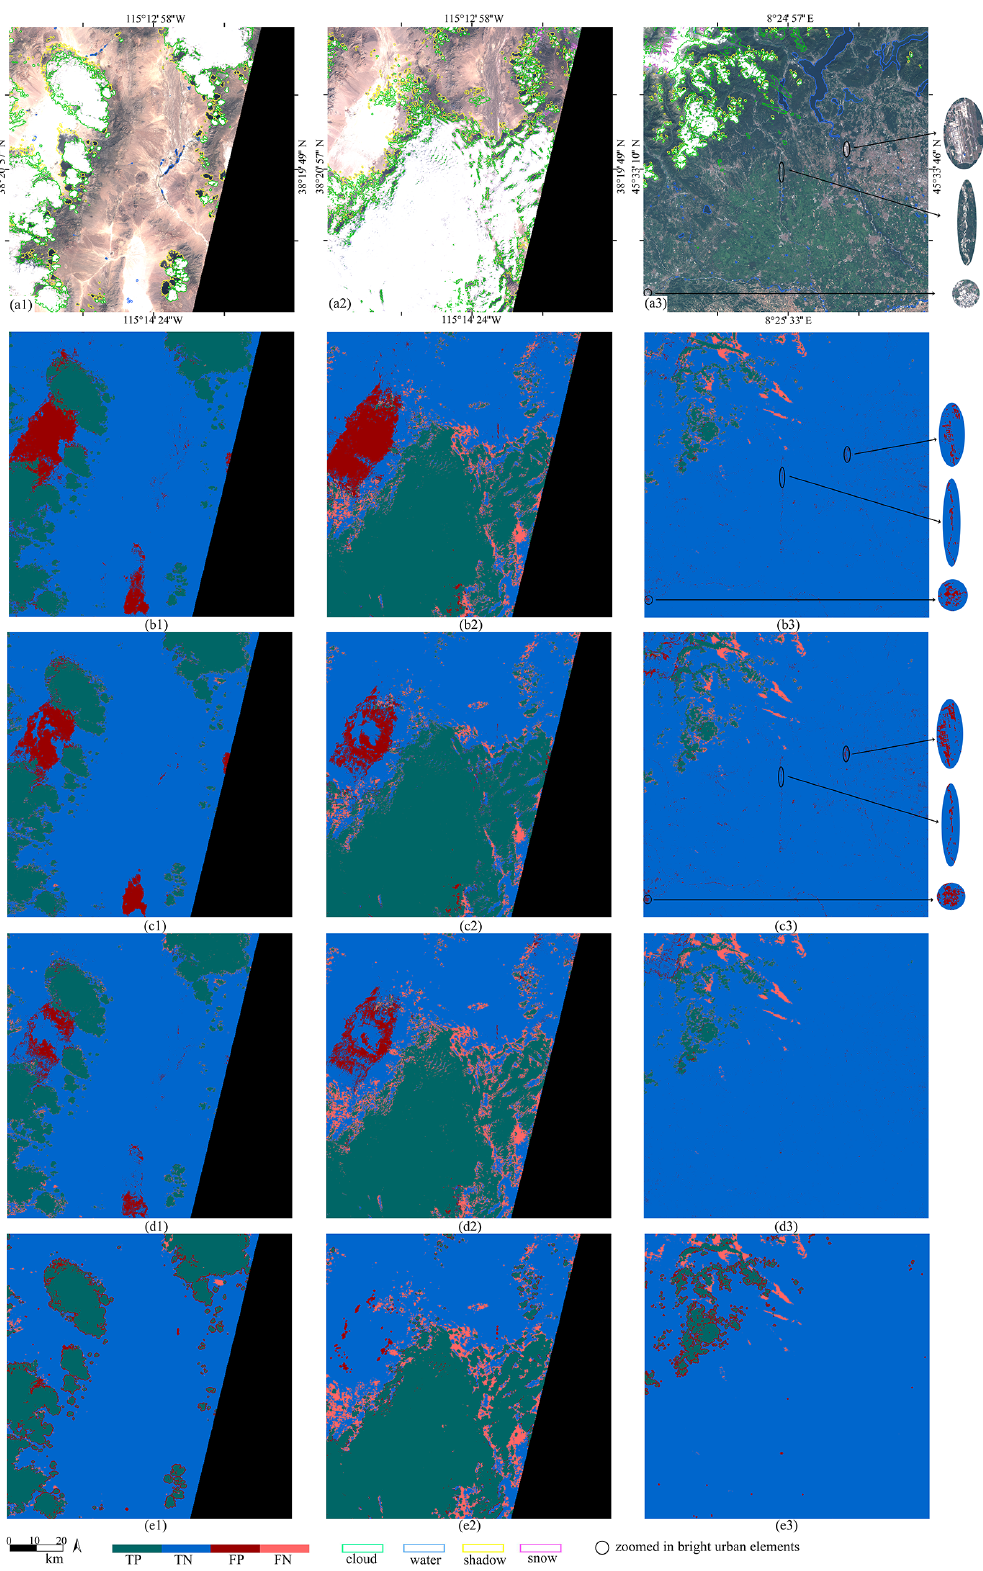
Figure 13. Cloud masks of Sentinel-2 images with bright non-cloud objects. ( a1 – a3 ): RGB composites with delineation of categories, ( b1 – b3 ): Sen2Cor cloud masks, ( c1 – c3 ): Fmask cloud masks, ( d1 – d3 ): SOM1 cloud masks, ( e1 – e3 ): SOM2 cloud